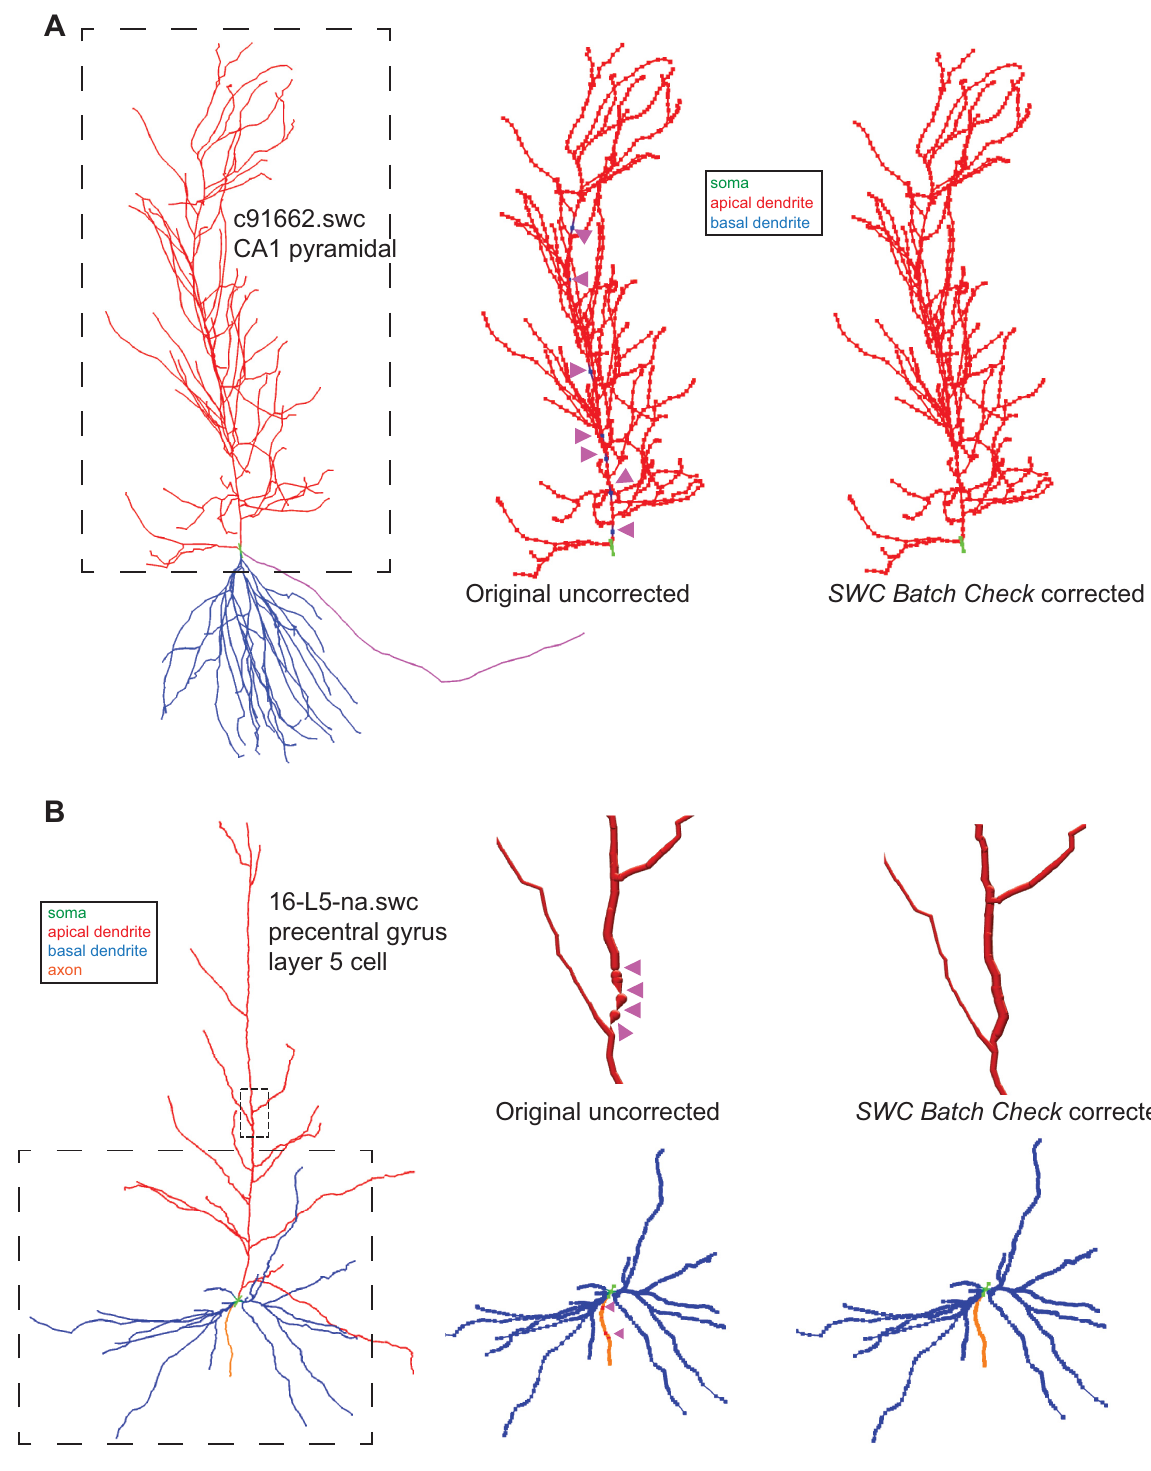
Fig 2. Testing SWC_BATCH_CHECK on real neuron reconstructions from NeuroMorpho . (A) Full reconstruction of a CA1 pyramidal cell ( NeuroMorpho ID NMO_00227; neuron name c91662) is shown in the leftmost image. Errors were introduced (arrowheads) to insert basal dendrite into the apical dendrite region (middle image). The apical region from the corrected output file using SWC_BATCH_CHECK with the correct apical dendrite syntactic structure is rendered in the rightmost image. (B) Reconstruction of a precentral gyrus layer 5 pyramidal cell ( NeuroMorpho ID NMO_05515; neuron name 16-L5-na) is shown in the